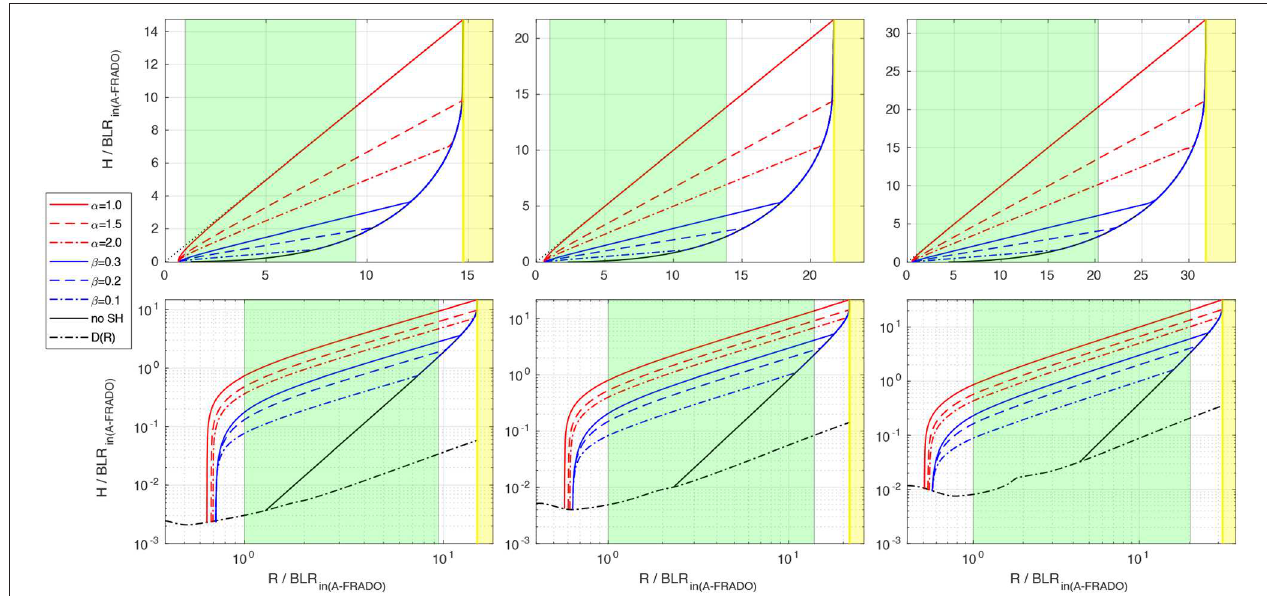
FIGURE 2 | Representation of the sublimation location above AD equatorial plane for Eddington rates of 0.01 (left panels), 0.1 (middle panels), 1 (right panels) in linear (upper panels) and logarithmic (lower panels) scales. Axes are normalized to BLR in from analytical FRADO model for the corresponding Eddington rate to be easily comparable. The area shaded in light-green covers the radial extension of BLR predicted by analytical FRADO model. Yellowish strip shows the inner part of torus. The onset of BLR and the thickness of AD are clearly visible in logarithmic panels, while in the linear ones the BLR radial extension for different accretion rates is easily